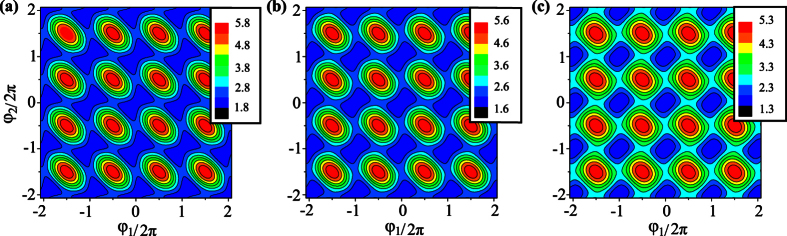
Contour plots of the potential U(φ1, φ2, φ3) at φ3 = 0 and fe = 1/2.(a) α = 1, β = 0.8, (b) α = 1, β = 0.6, and (c) α = 1, β = 0.3.